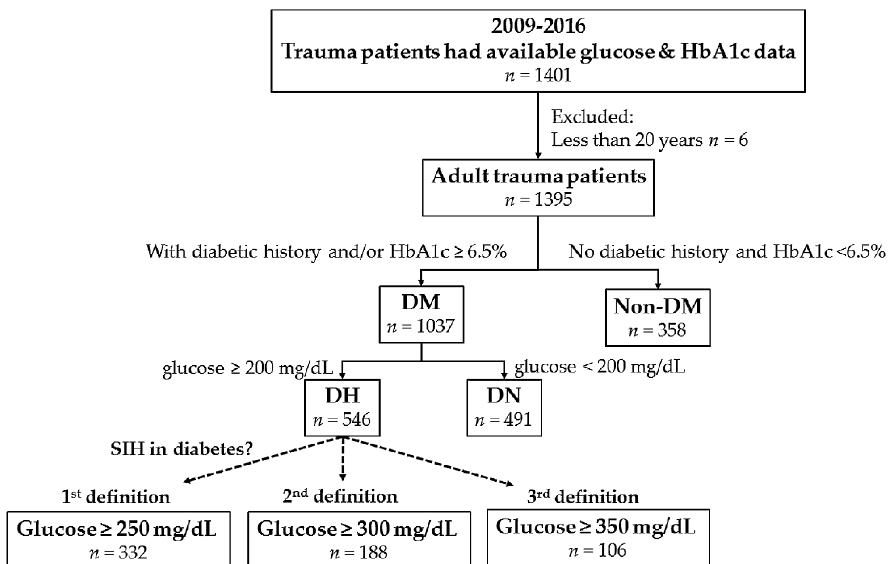
Figure 1. Flow chart to divide patients into diabetes mellitus (DM), non-diabetes mellitus (non-DM), diabetic normoglycemia (DN), diabetic hyperglycemia (DH), and stress-induced hyperglycemia, in diabetes groups, based on various glucose levels, SIH: stress-induced